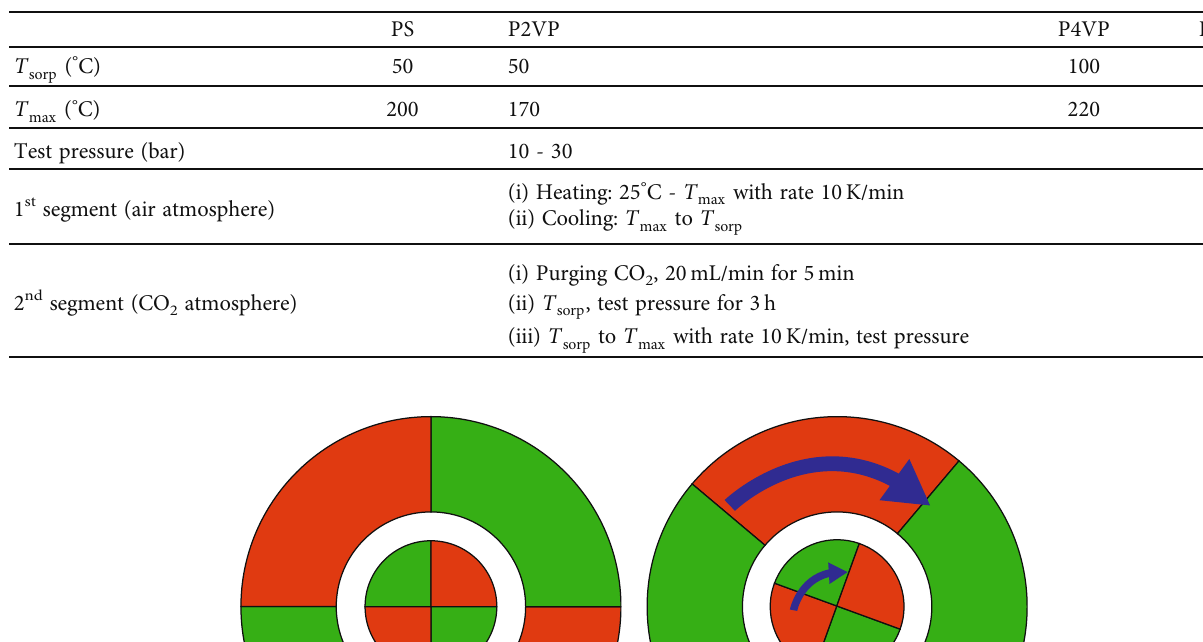
Table 3: Speci fi cations of the HP-DSC experiments.